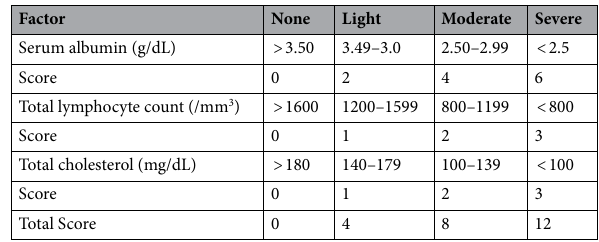
Table 1. Evaluation of the nourishing status utilizing the CONUT